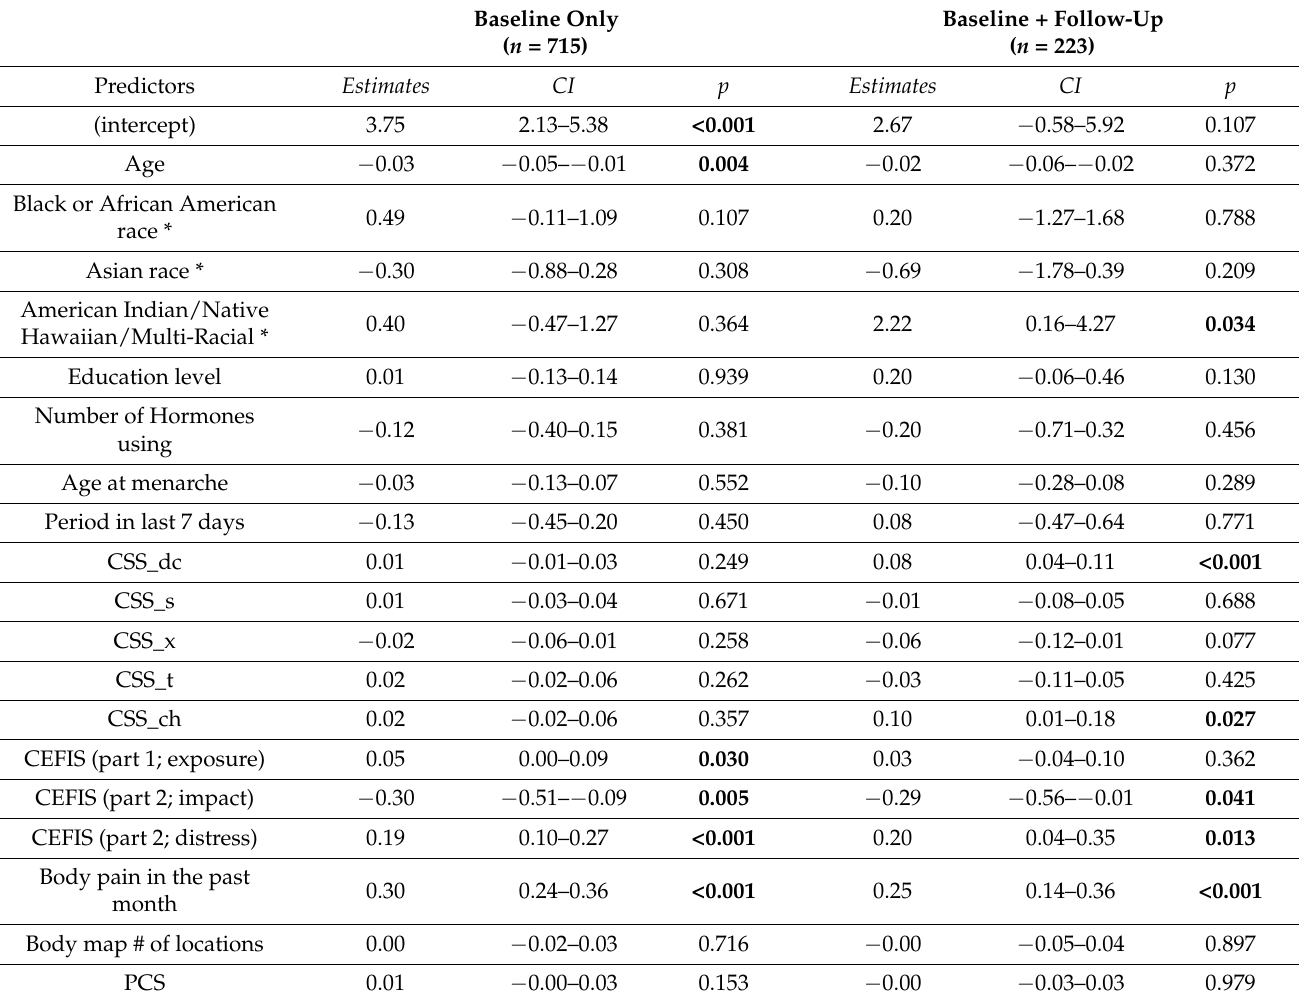
Table 5. Predictors of Menstrual Pain Interference in participants who completed the baseline assessment only and those who completed both baseline and follow-up